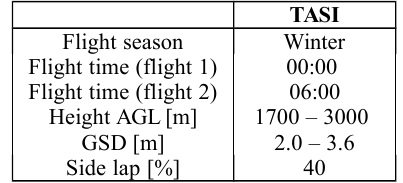
Table 4. Standard thermal behaviour flight